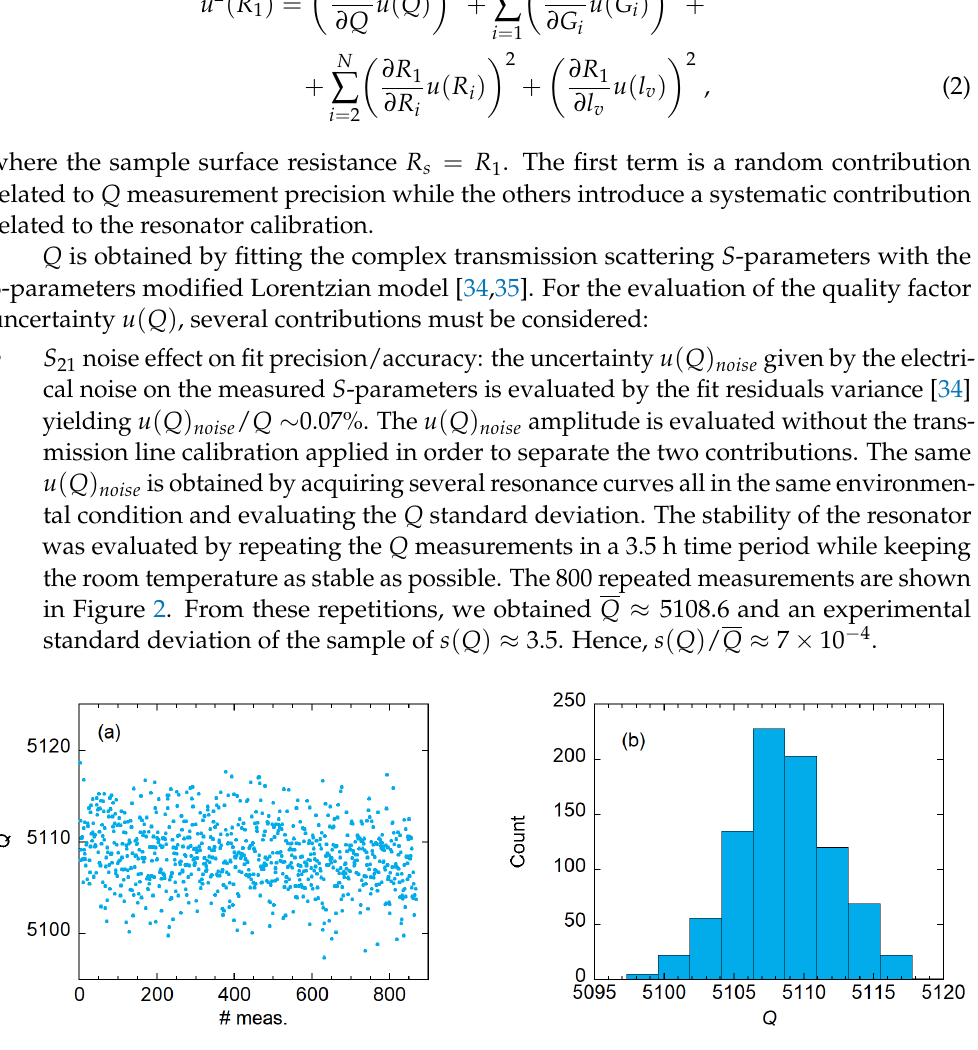
Figure 2. A total of 800 repeated Q -factor measurements were made with the resonator kept at fixed room temperature and without unmounting the sample. Measurement repetition and measurement histogram are shown in panels ( a ) and ( b ),